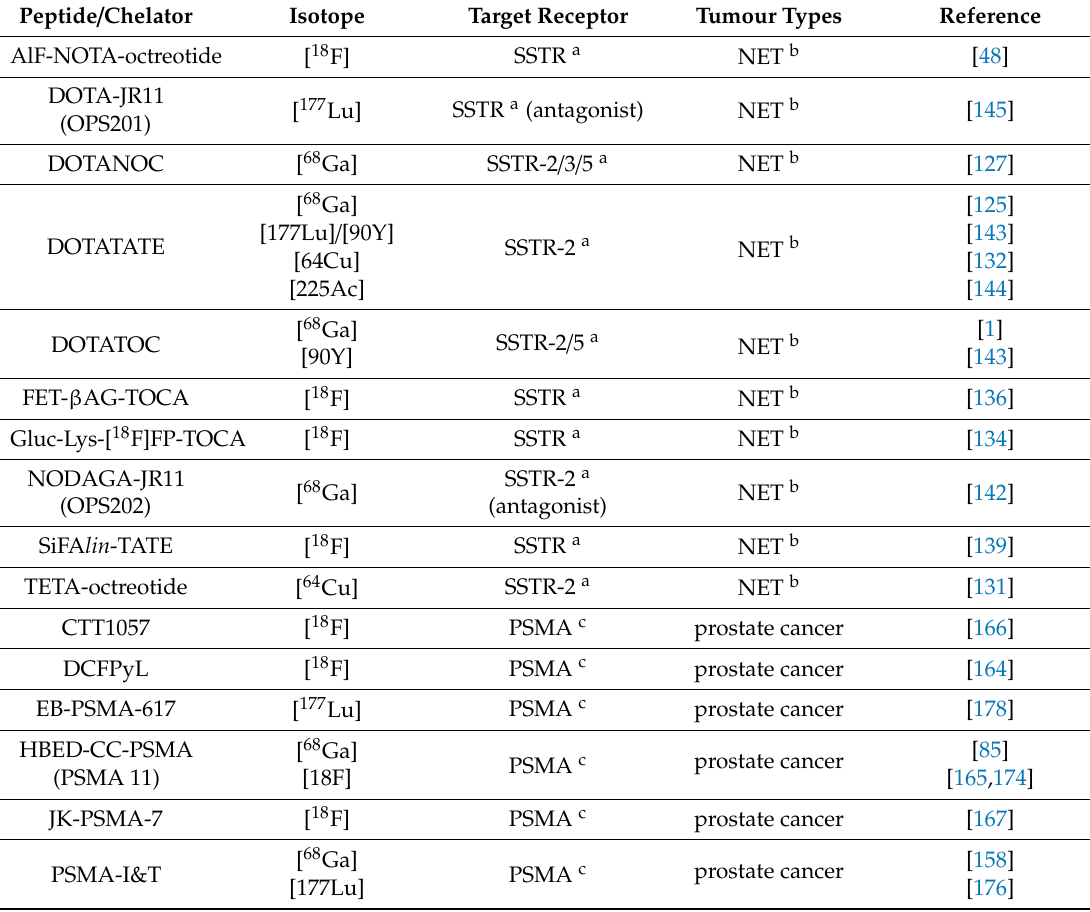
Table 3. Peptides used in clinical trials or clinical routine PET